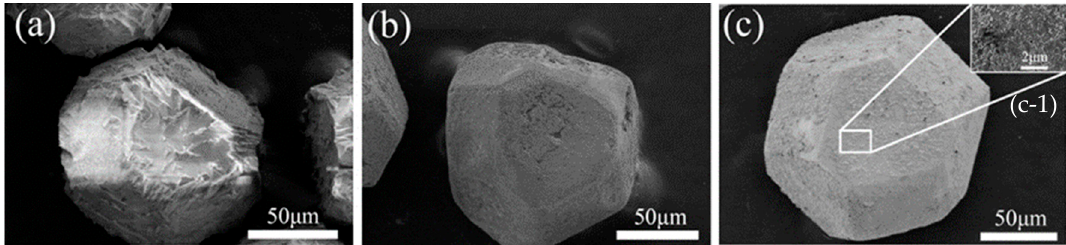
Figure 7. SEM images for ( a ) uncoated diamond, ( b ) B 4 C-coated diamond and ( c ) Cr–B–C-coated diamond, after annealing at 1151 °C: ( c-1 ) the squama on diamond surface.